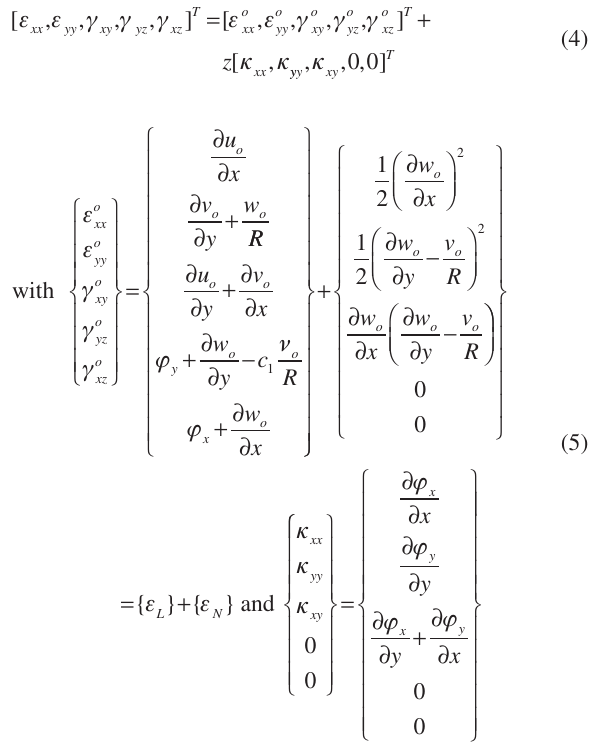
The strain-displacement relations, corresponding to different shell theories, are considered in the case of small deforma- tions of a curved plate with radius R and written in terms of the mid-plane displacement fi eld ( u global coordinate system (x, y, z). Further, ϕ the rotations due to shear deformation. The tracer coeffi cient c is introduced to express the strain-displacement relations 1 corresponding to the two different shell theories for a shallow ( h / R < < 1) curved plate. The strain fi eld can be expressed tk